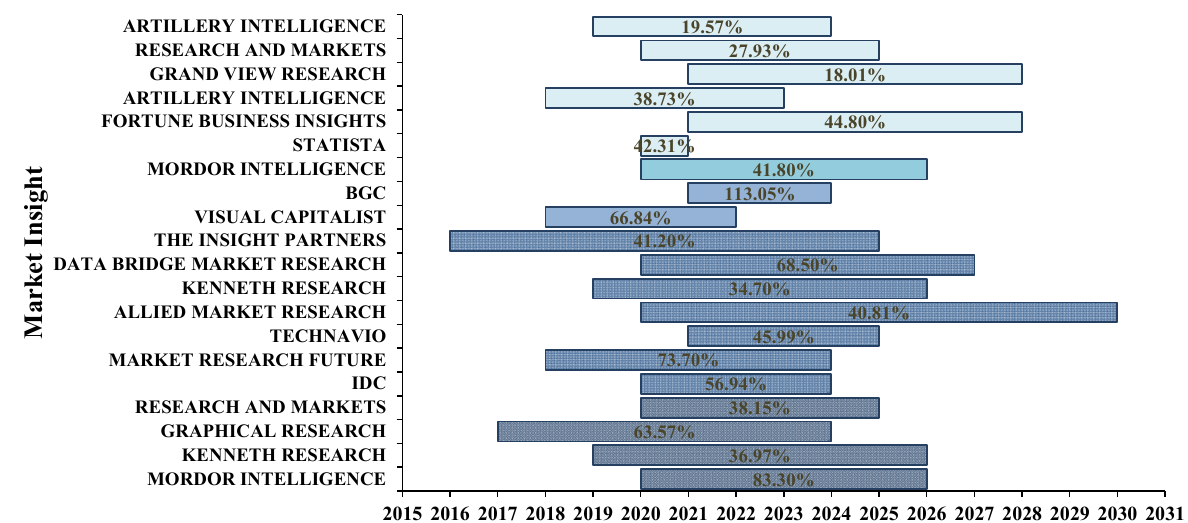
Figure 8. Estimated compound annual growth rate for immersive technologies market value (source—[117–119]).